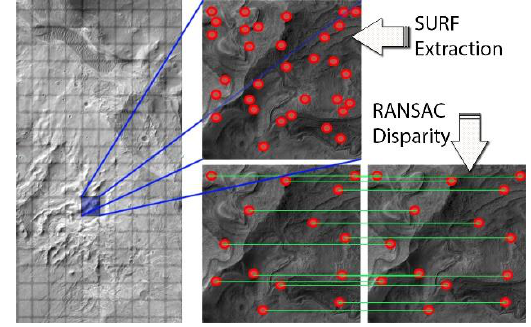
Figure 2: Tile based Strategy implemented in